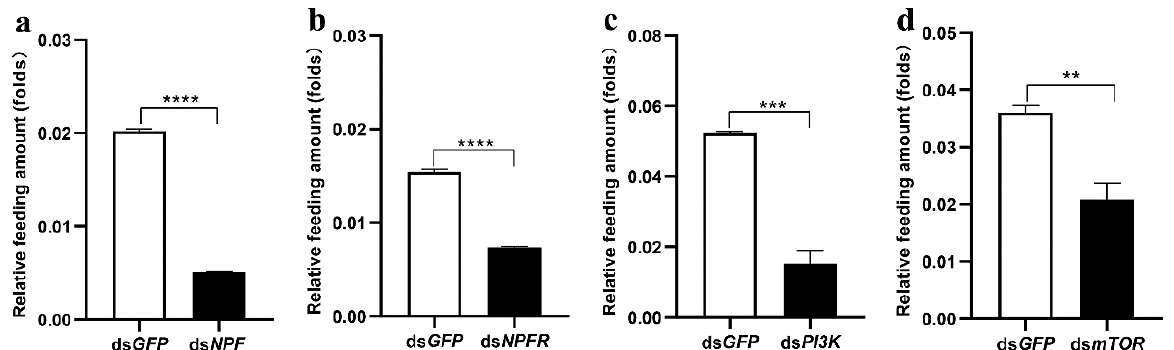
Figure 2. Feeding regulation by NPF, NPFR, PI3K, and mTOR. Relative feeding amount of 5th instar larvae with knockdown of NPF ( a ), NPFR ( b ), PI3K ( c ), and mTOR ( d ), respectively, for 24 h. Each treatment was repeated 3 times with 10 individuals per replicate. Bars represent the mean ± SE. ** p < 0.01, *** p < 0.001, **** p < 0.0001.